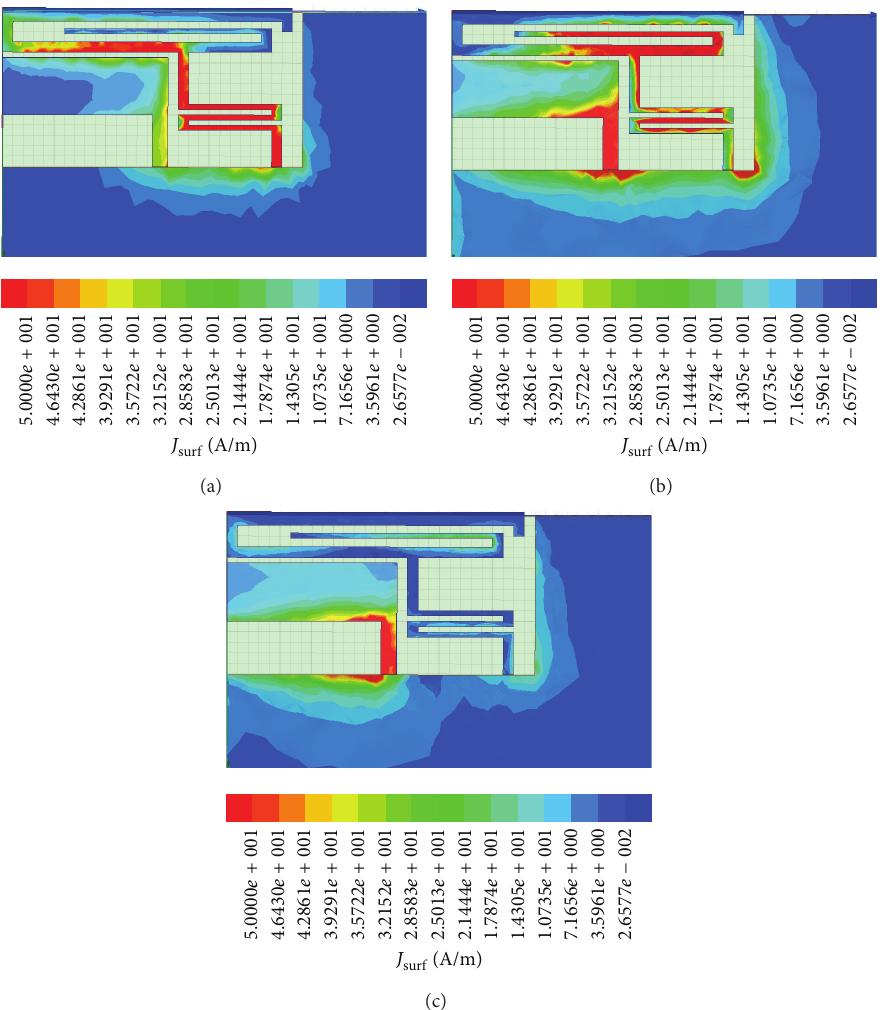
Figure 4: Simulated surface current distributions on the printed metal strip for the proposed antenna at (a) 860 MHz, (b) 1.9GHz, and (c) 2.65